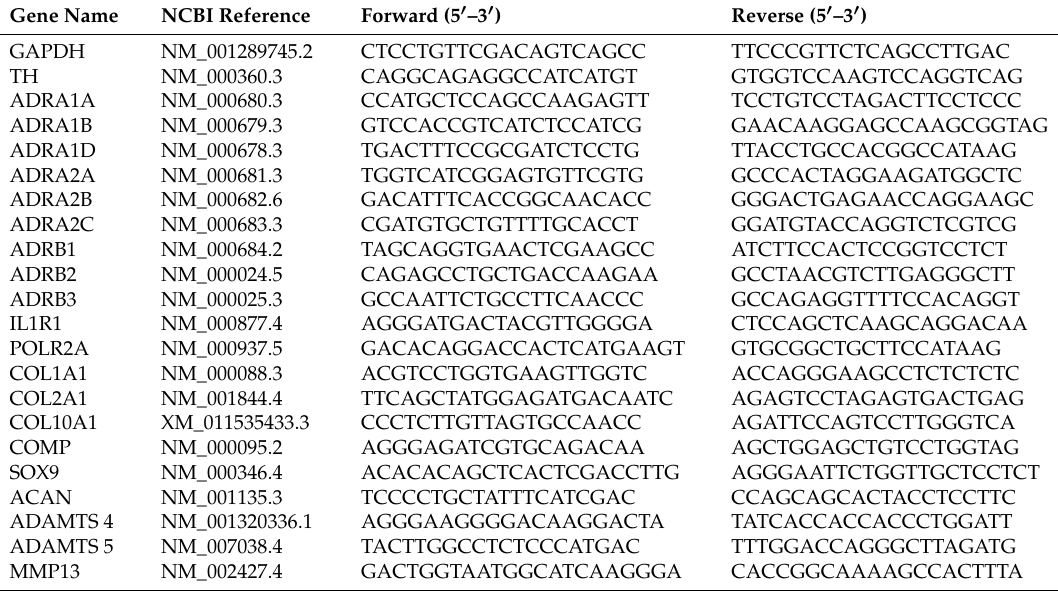
Table 2. The primers used for